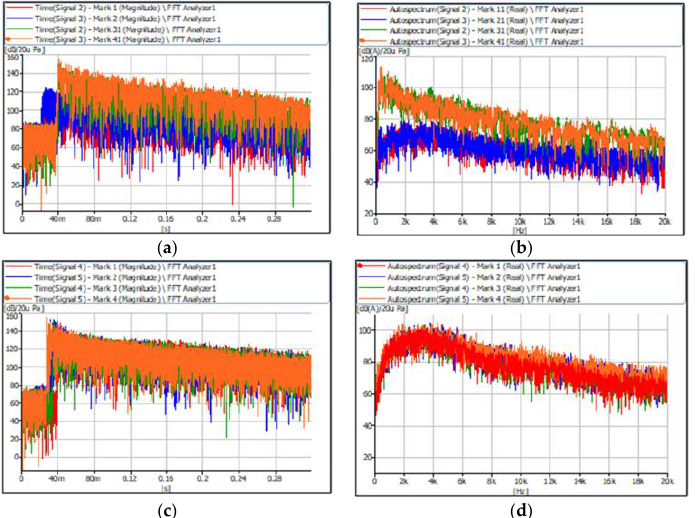
Figure 4. Graphs comparing the sound pressure at 4 points (Figure 3) with and without the damping system, showing the temporal ( a , c ) and spectral density plots ( b , d ) of the sound pressure. A damp- ing system is used with the red and blue curves, and the green and orange curves describe when a damping system is not used. The results of the sound pressure measurements (Figure 4) during the shot showed that the values of the damping device in the shooter area are reduced by 30.2 dB at point 1 and 30.1 dB at point 2 compared to when the damping device was not used. When eval- uating the results of the sound pressure measurements at points 3 and 4, it was found that the silencer had almost no effect on the sound pressure value at point 3 (with damping device 153, without damping device 153.9 dB) and point 4 (with damping device 153.9, without damping device 155 dB). An investigation of acoustic characteristics of silencer configurations was performed. In the second configuration, the spaces between the partitions are separated (Figure 5), thus isolating the gas expansion chamber and changing the effect on the acoustic charac- teristics. The three-dimensional model of finite elements is divided into a structure of 201,035 points and 103,438 elements.